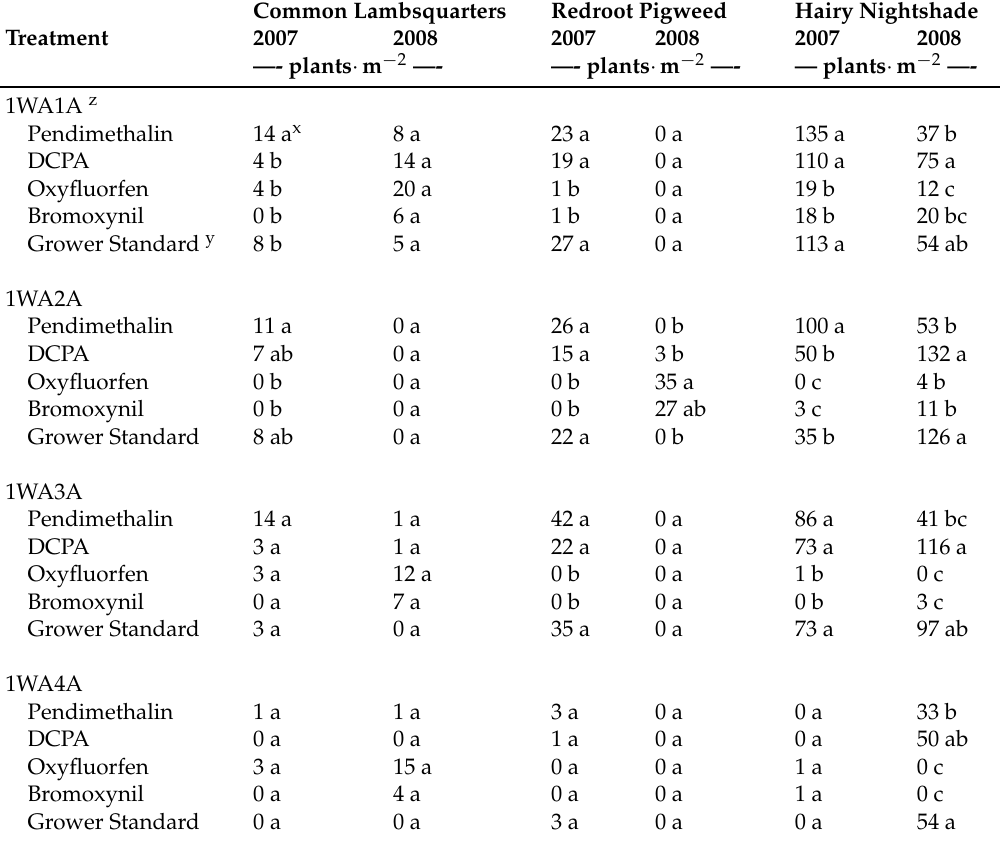
Table 2. Common lambsquarters ( Chenopodium album ), redroot pigweed ( Amaranthus retroflexus ), and hairy nightshade ( Solanum physalifolium ) densities following herbicide applications at Oakes, ND, USA, during 2007 and 2008.